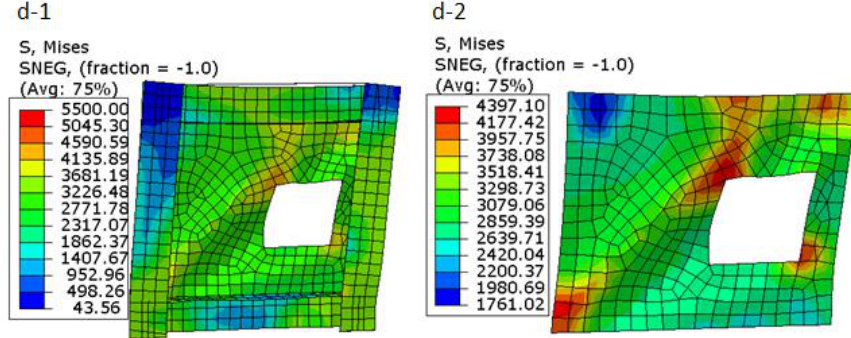
Figure 14. Von Mises stress for shell part (d-1) frame part and (d-2) steel plate.